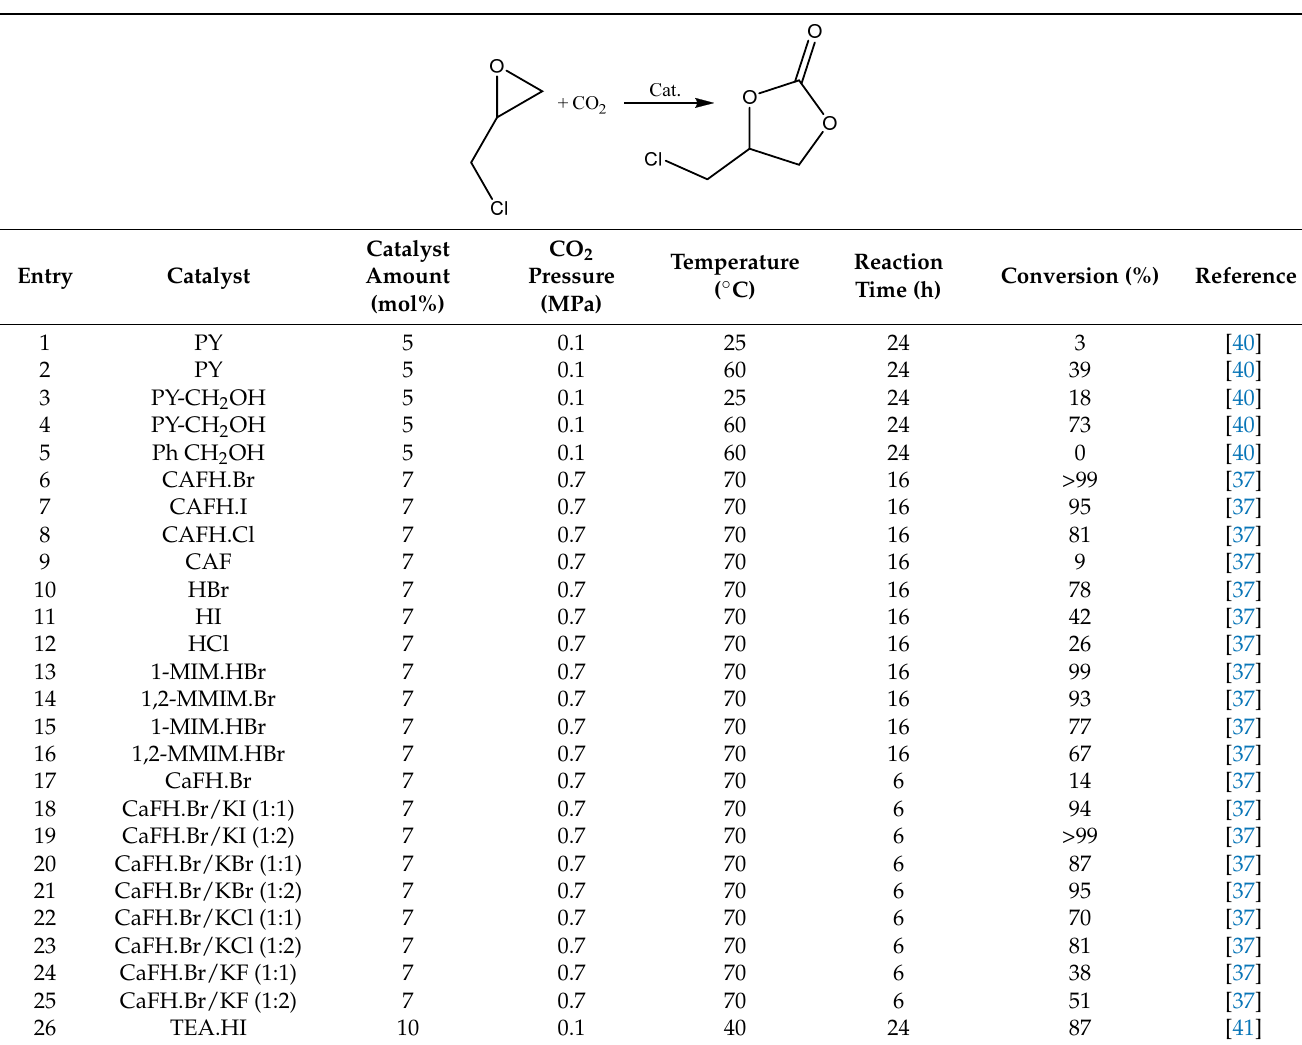
Table 4. Catalyst screening for the cycloaddition of EPIC.